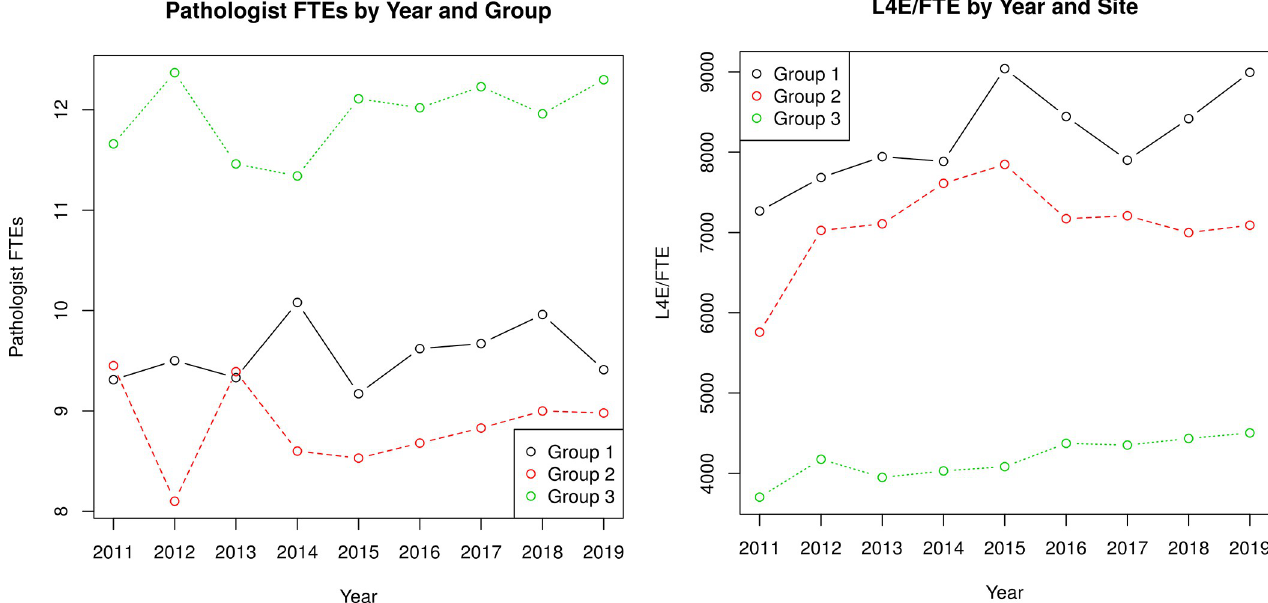
Fig 1. a: Number of full-time equivalents (FTEs) by group and year. b: Level 4 equivalent (L4E) workload units per full-time equivalent FTE by group and year.